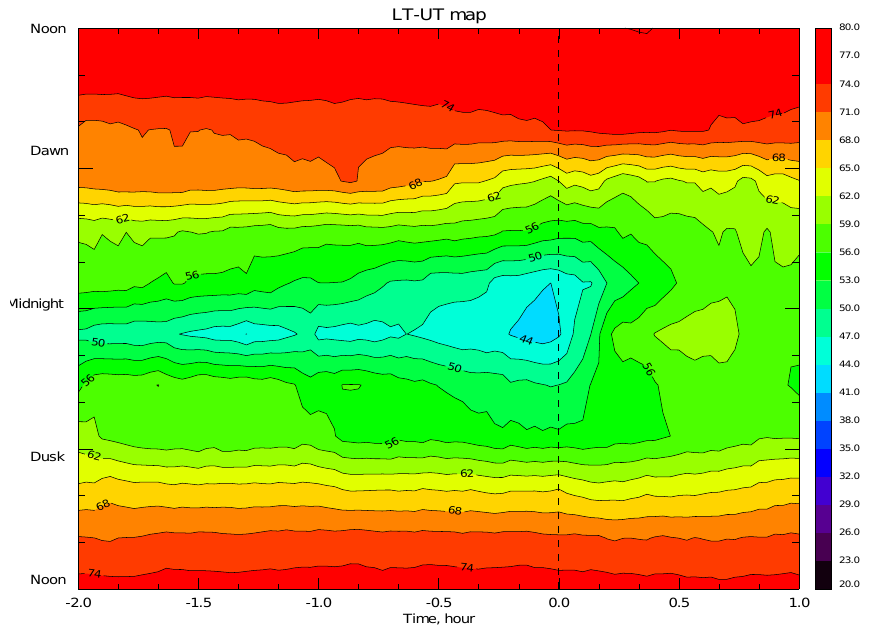
Fig. 3. Local time–universal time contour plot of the tilt angle during isolated substorms. The tilt angle is plotted from 20 ◦ to 80 ◦ . The contour level is 3 ◦ . Local midnight is in the middle and local noon is on the top and bottom. The dashed vertical line marks the onset time of substorms.